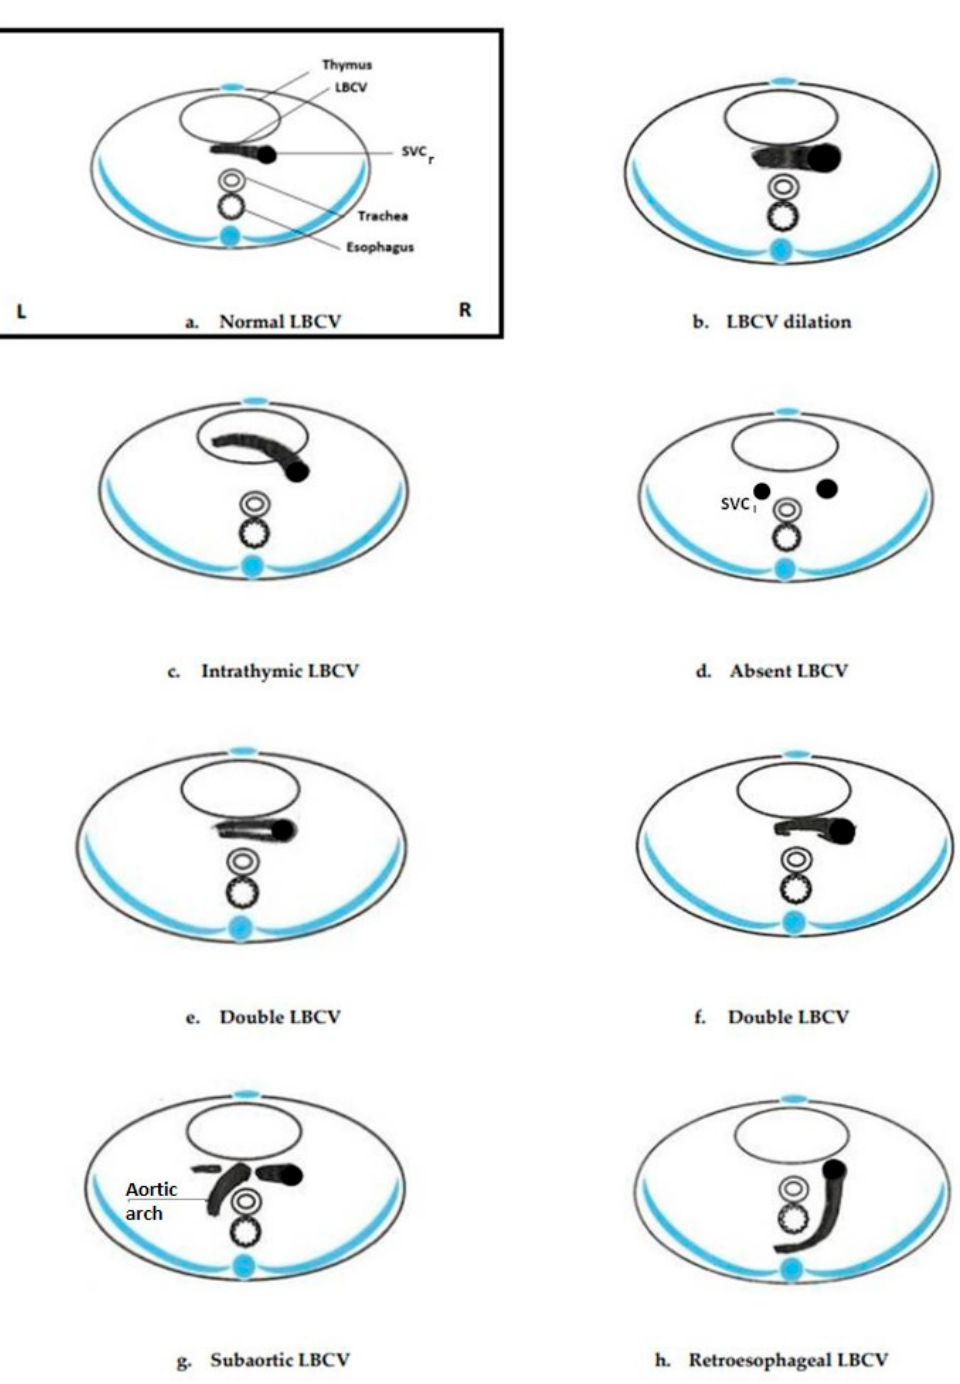
Figure 4. Illustration of transverse sections of the upper mediastinum as seen on an ultrasound scan with the left brachiocephalic vein (LBCV) recognizable: ( a ) normal LBCV; ( b ) LBCV dilated; ( c ) intrathymic LBCV; ( d ) absent LBCV with LSVC; ( e , f ) double LBCV; ( g ) subaortic LBCV; ( h ) retroesophageal LB. SVCr = right superior vena cava; SVC l = persistent left superior vena cava; L = fetal left side; R = fetal right side.